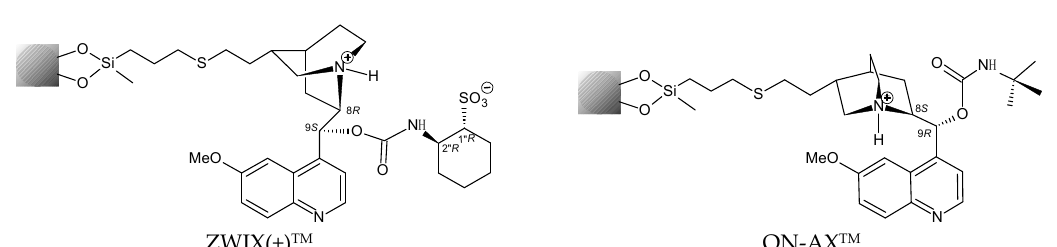
Figure 1. Structure of analytes.